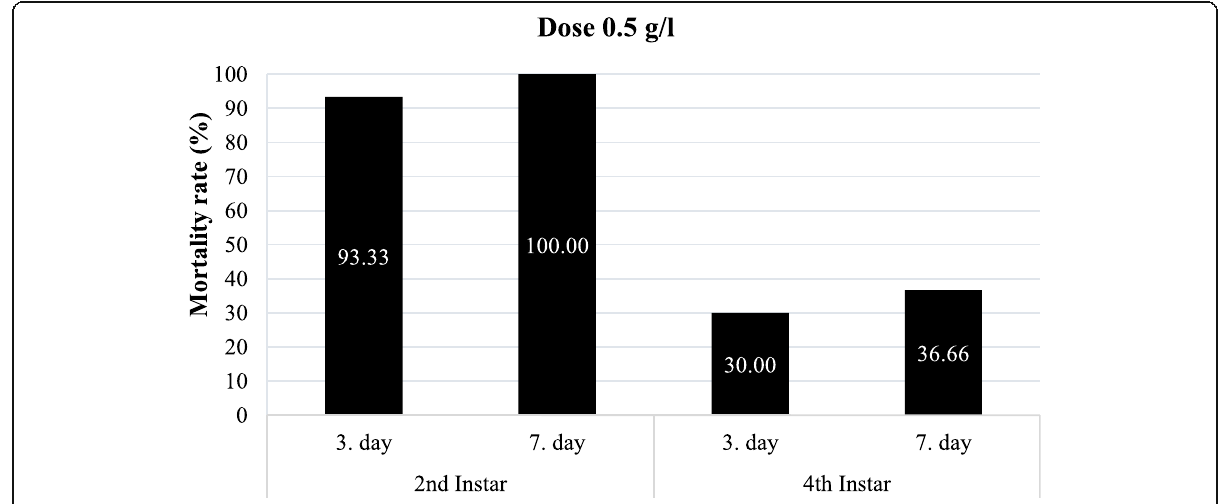
Fig. 3 Effects of Bacillus thuringiensis var. thuringiensis (0.5 g/l concentration) against 2nd and 4th larval instars of Syllepte